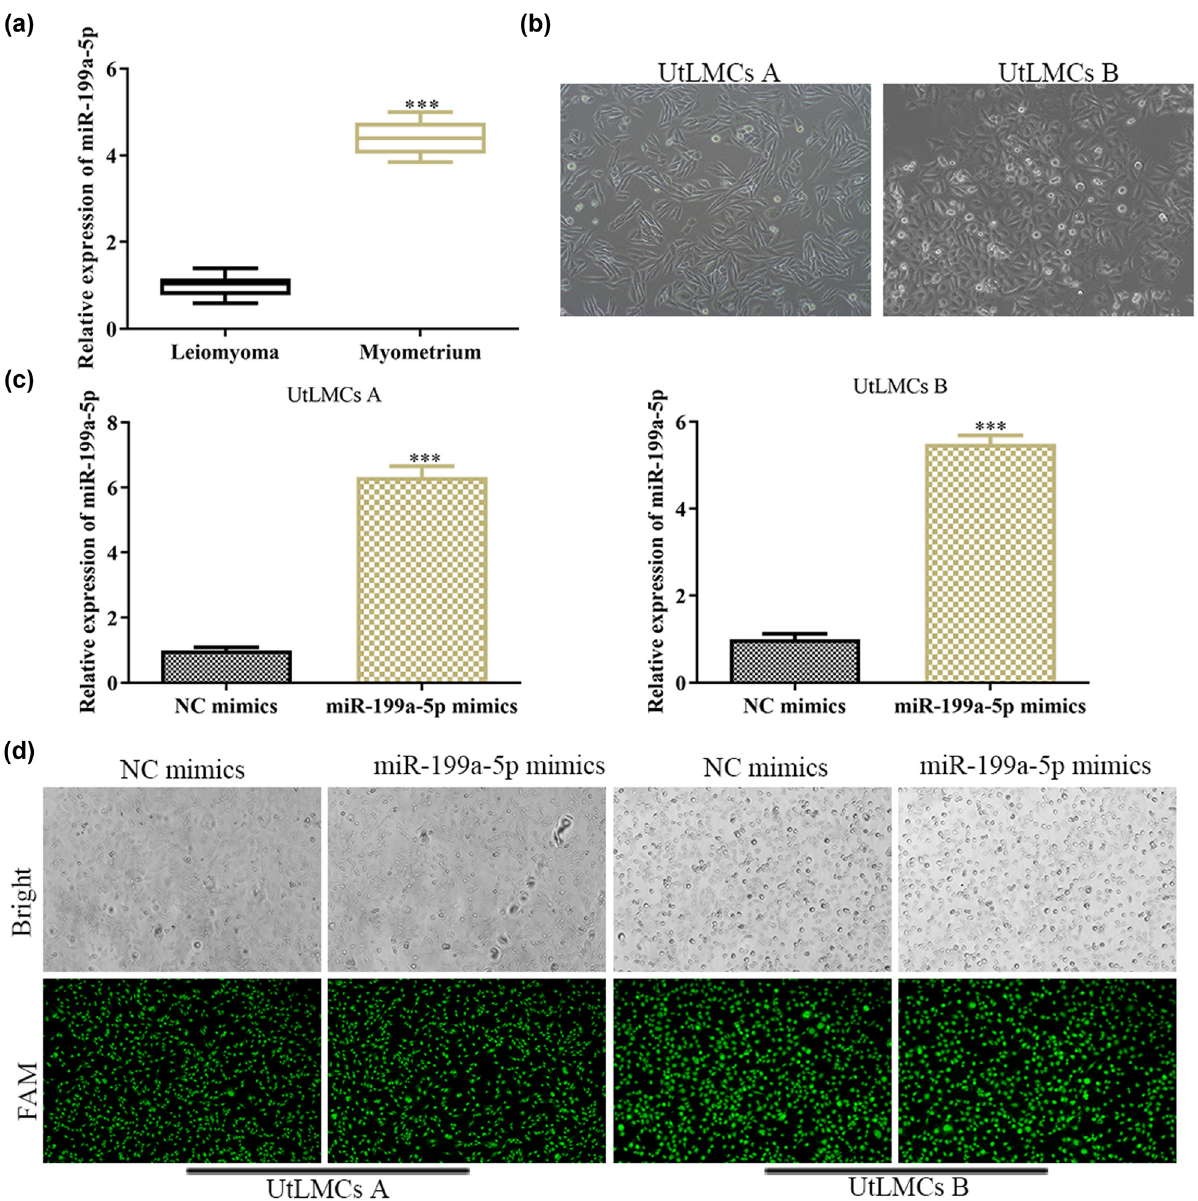
Figure 1: MiR - 199a - 5p is downregulated in ULM. ( a ) Relative expression level of miR - 199a - 5p in 40 paired ULM tissues and adjacent normal myometrium tissues. ( b ) Comparison of the morphological characteristics of human UtLMCs. ( c ) qPCR analysis of expression level of miR - 199a - 5p and ( d ) GFP fl uorescence analysis of the transfection e ffi ciency of miR - 199a - 5p mimics. All values are presented as mean ± SD from at least three separate experiments. *** P < 0.001 vs NC mimics